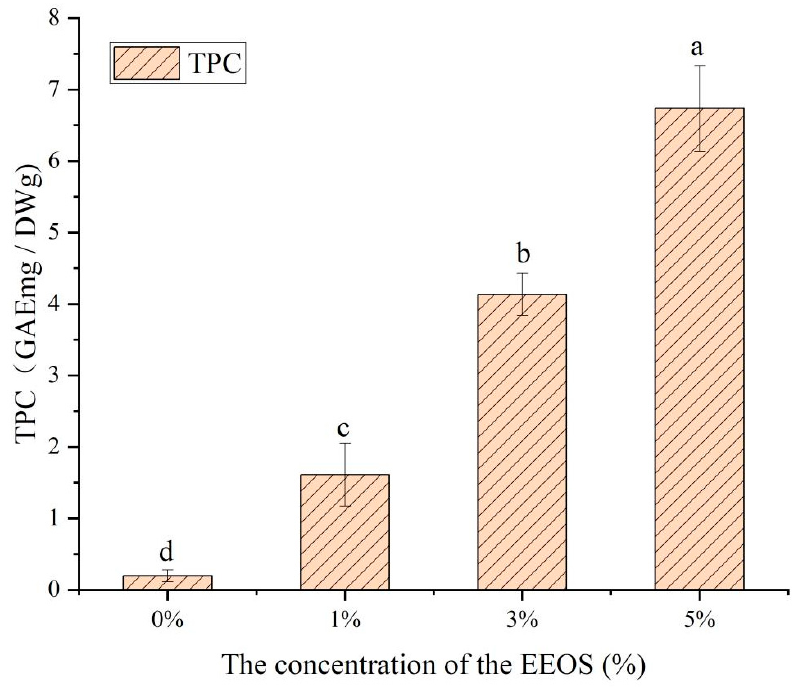
Figure 7. Total phenol contents of the CS/ κ C, CS/ к C/EEOS I, CS/ к C/EEOS II, and CS/ к C/EEOS III composite films. a–d Values are given as means ± standard deviation. Different letters in the same line indicate significant difference ( p < 0.05).